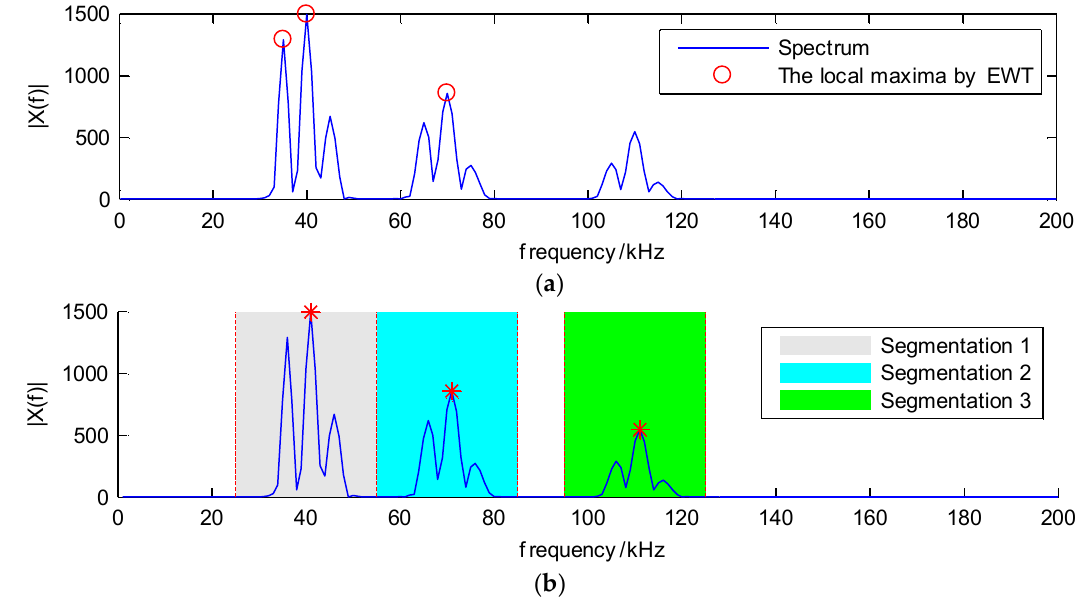
Figure 7. Local maxima by ( a ) the original EWT method denoted by red circles and ( b ) the LWM method denoted by red stars; the spectrum segmentation results are shown by the color of gray, cyan and green.